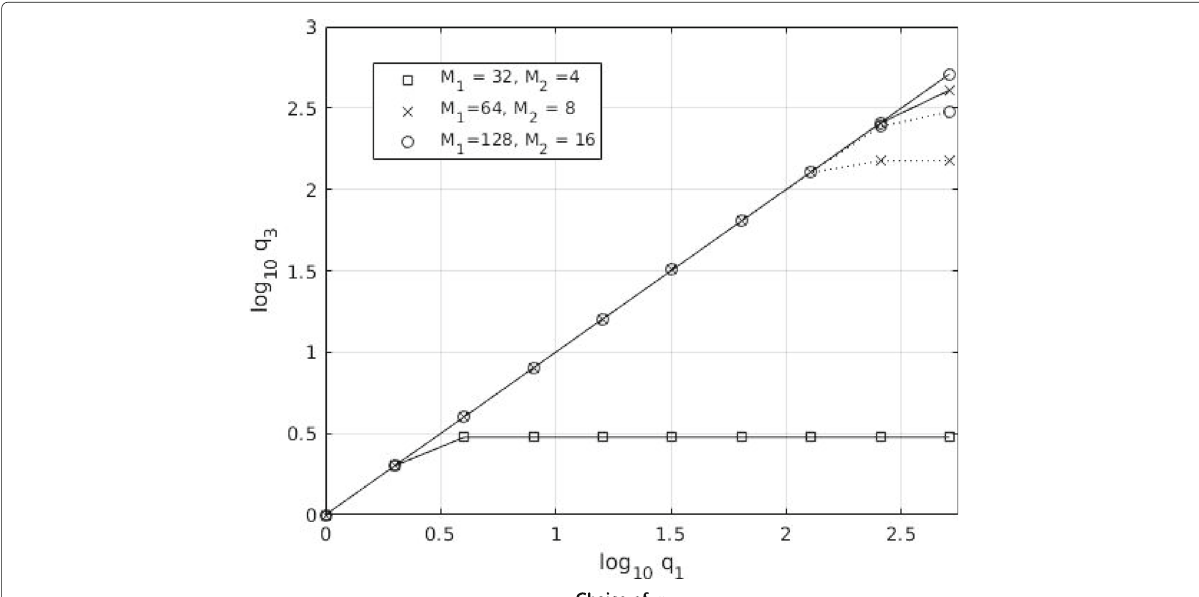
Fig. 12 Choice of q 3 . Number of iterations q 3 (in log scale) vs the number iterations q 1 (in log scale) for a ULA system with N r = 32 and N t = 4 for AGDAR (solid lines) and RCS (dotted lines). UMi LOS